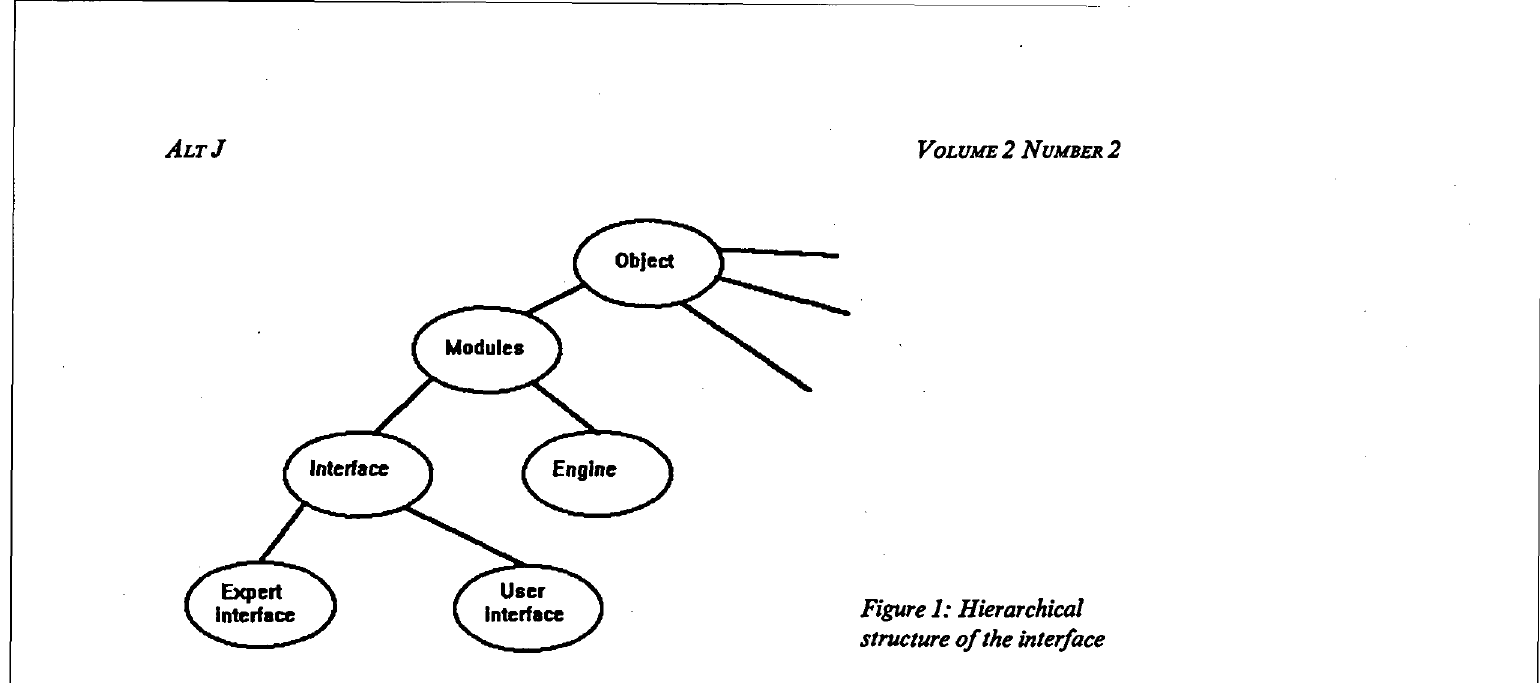
Figure 1: Hierarchical structure of the